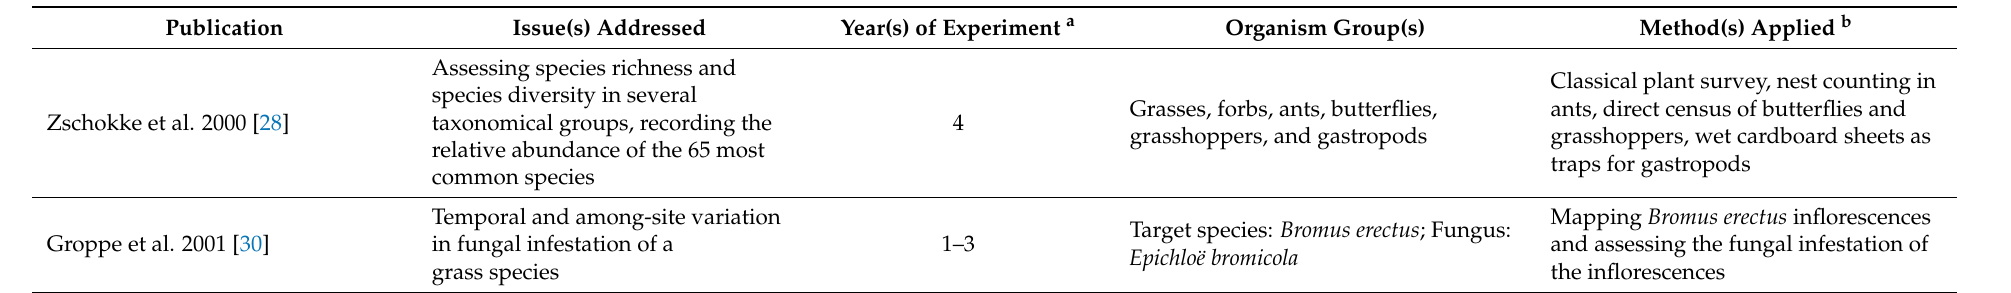
Table 2. Overview of publications presenting findings of the grassland fragmentation experiment in the Swiss Jura